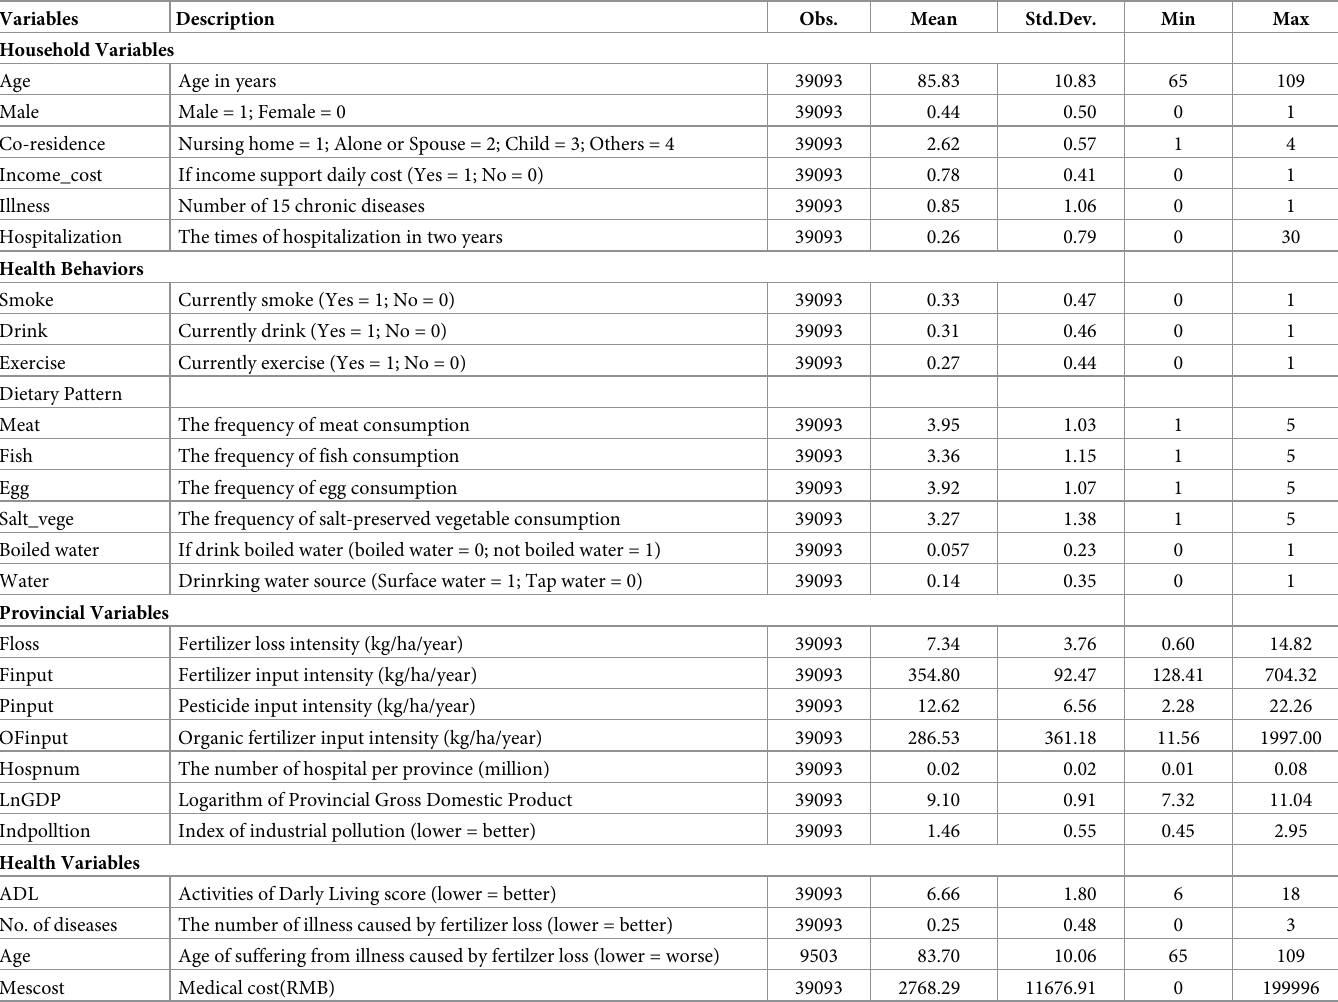
Table 1. Variable description and summary